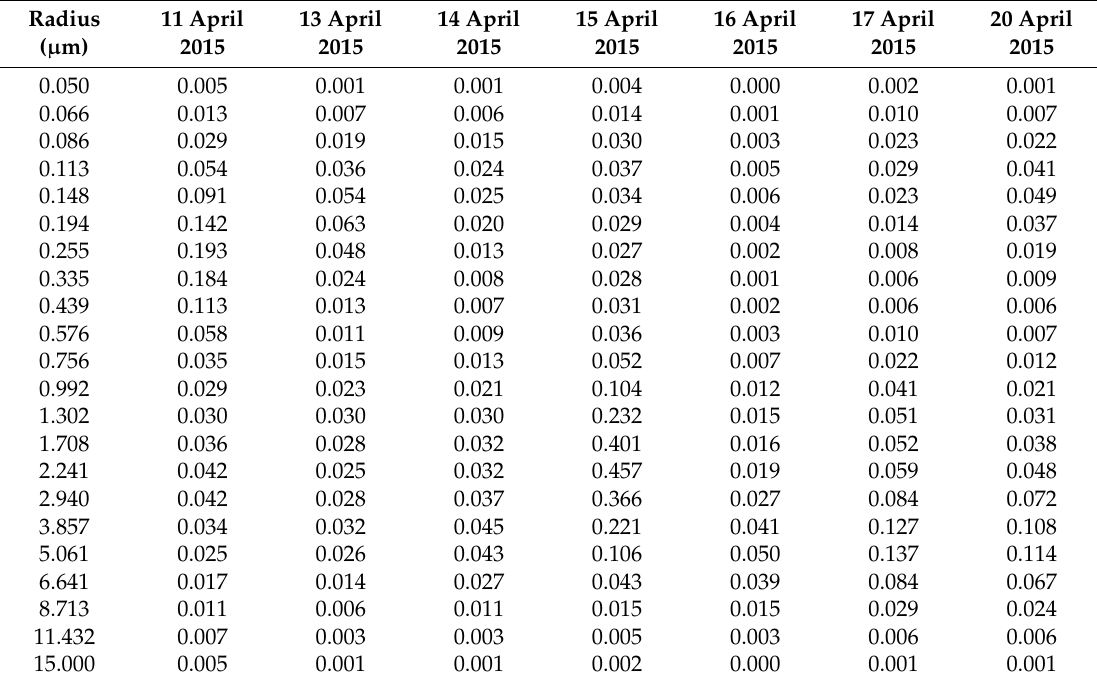
Table 1. Daily average variations of aerosol size distribution (dV/dlnR ( µ m 3 / µ m 2 )) during dusty and non-dusty